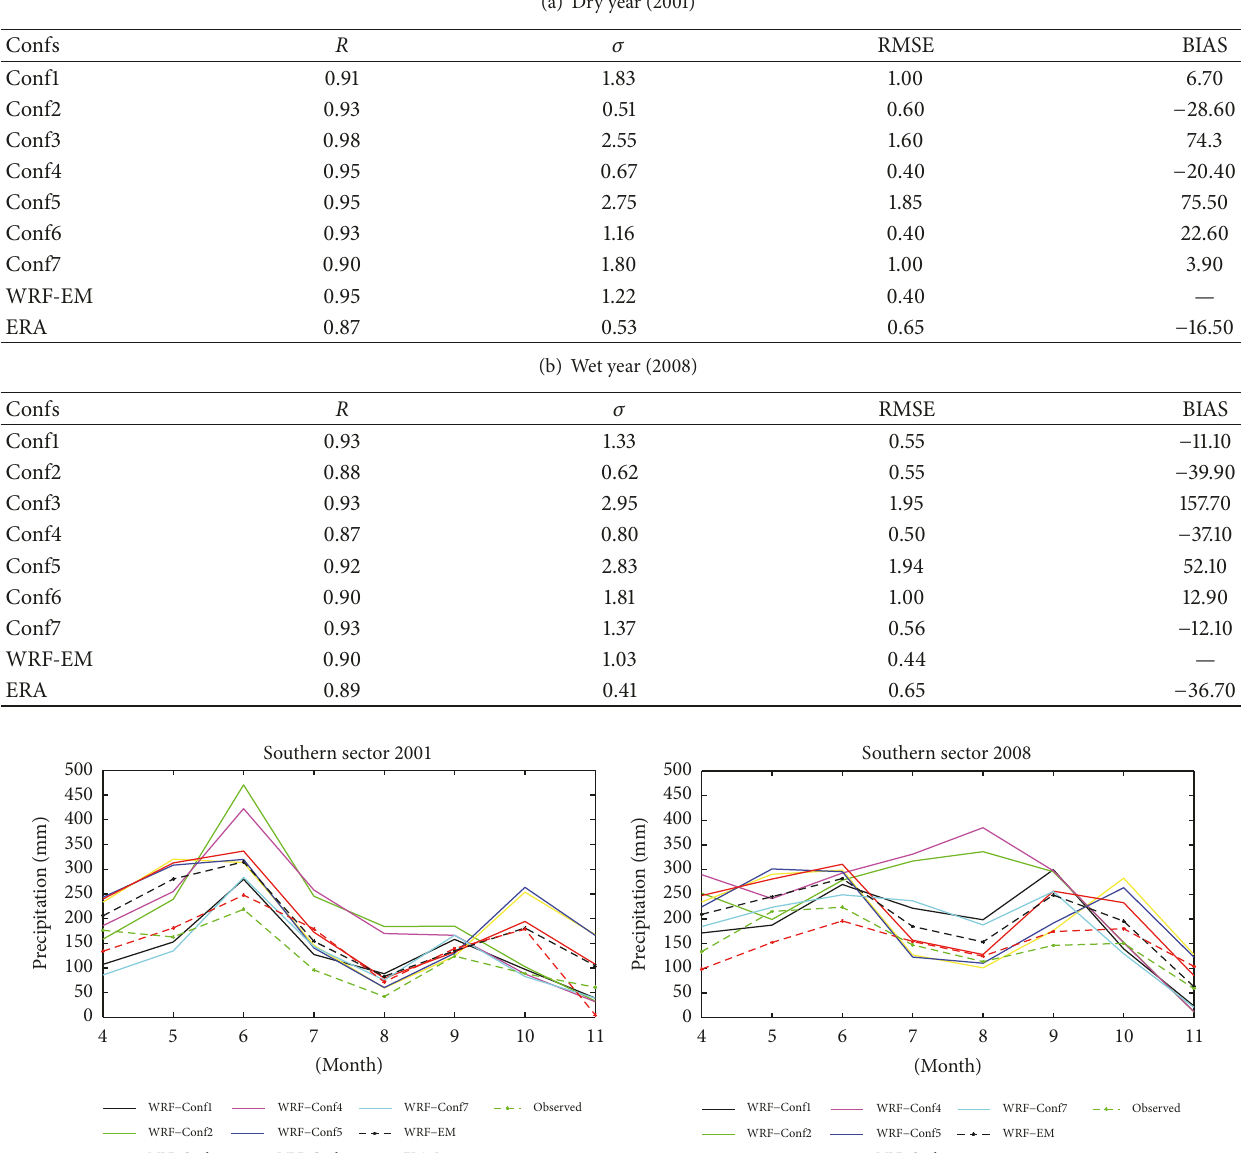
Table 7: The four different statistic, for the northern zone, (a) for the dry year and (b) for the wet year.